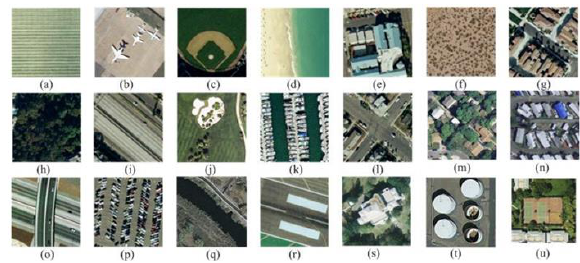
Figure 3. UC Merced dataset. (a)–(u): agricultural, airplane, baseball diamond, beach, buildings, chaparral, dense residential, forest, freeway, golf course, harbor, intersection, medium residential, mobile home park, overpass, parking lot, river, runway, sparse residential, storage tanks, and tennis courts.